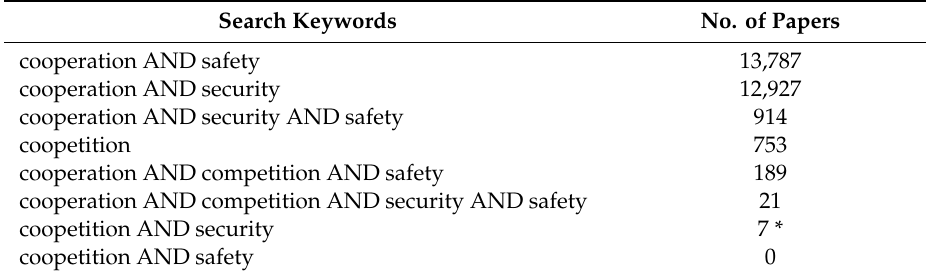
Table 1. The search results (SCOPUS Database) for several combinations of keywords, for the whole period that ends in 2018.